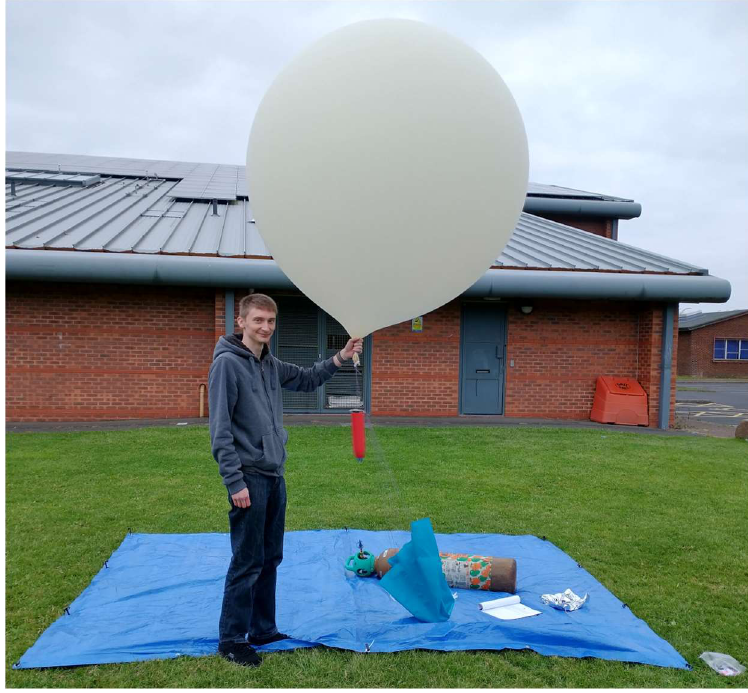
Figure 27. Balloon and payload ready for launch. The initial flight ascended at the rate of climb predicted and followed the ground track as predicted. Figure 28 shows the planned trajectory (black line), the actual trajectory (red dots) and the estimated descent trajectory (yellow line). Figure 29 shows the 3-dimensional plot of the predicted trajectory.